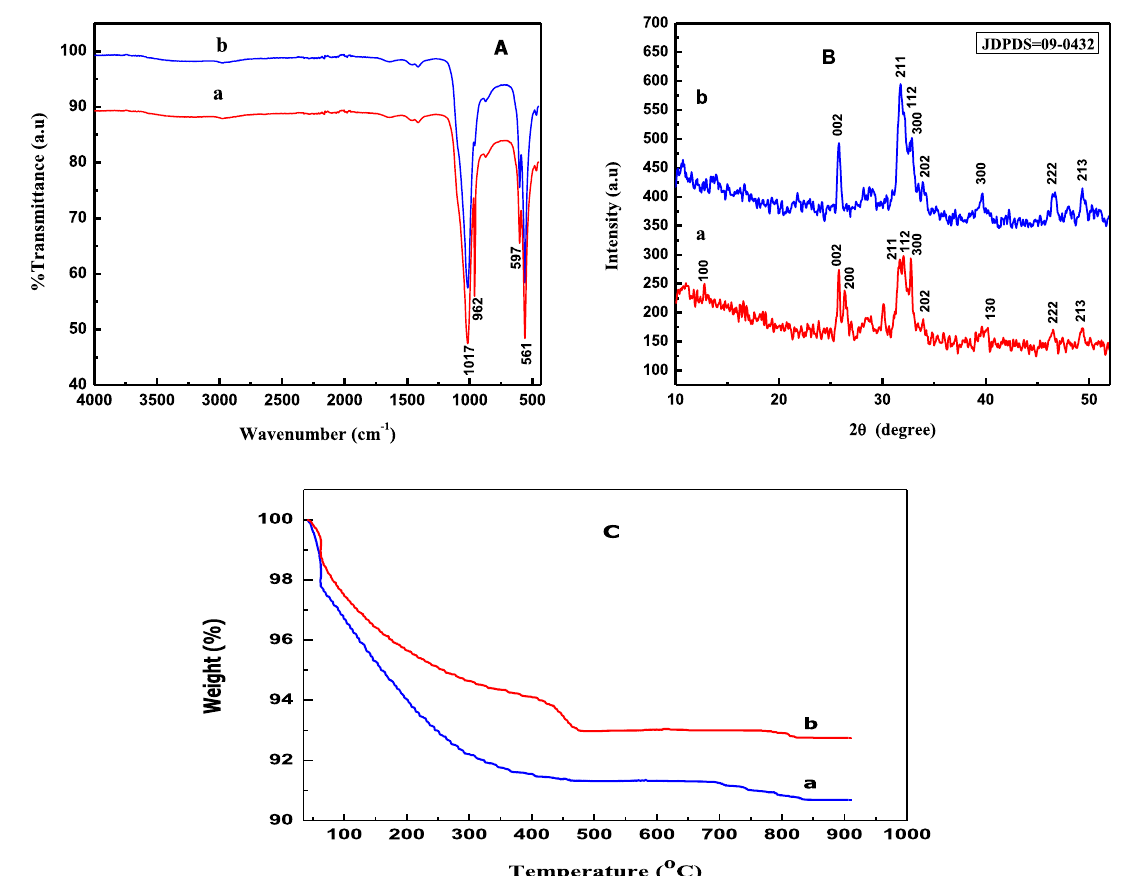
Fig. 2 A FT-IR spectra, B XRD spectra, and C TGA curves of WHA ( a ) and CHA ( b )